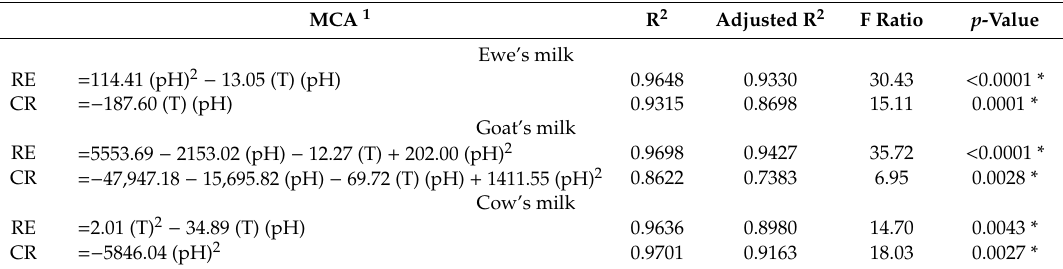
Table 4. Models for the milk clotting activity